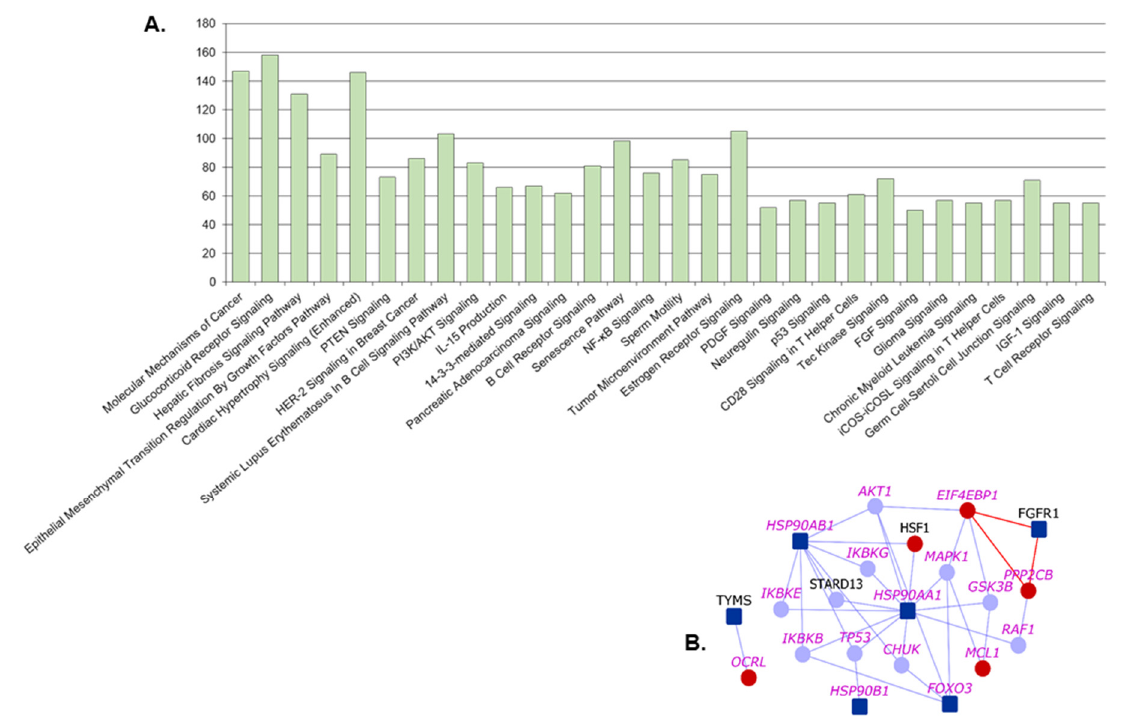
Figure 4. Pathways associated with malignant pleural mesothelioma (MPM) interactome: ( A ) Number of genes from MPM interactome associated with various pathways are shown. Top 30 pathways based on significance of association with the interactome are shown. ( B ) PI3K/AKT Signaling Pathway: Dark blue nodes are MPM genes, light blue nodes are known interactors and red nodes are novel interactors. Nodes with purple labels are genes involved in the PI3K/AKT signaling